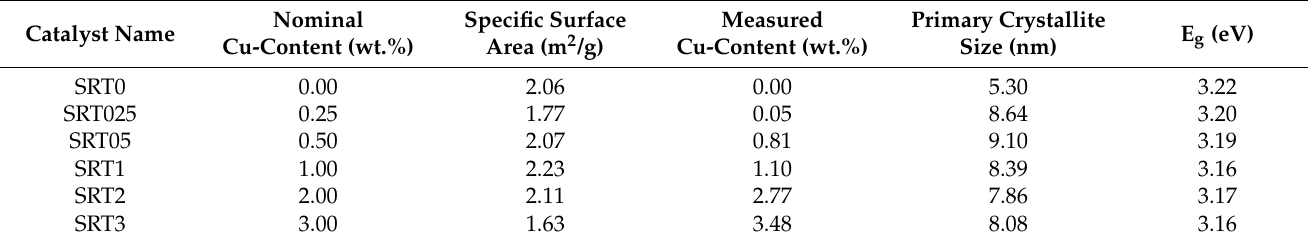
Table 1. Nominal and measured Cu contents, specific surface area values and the primer crystallite size of the synthetized catalysts.